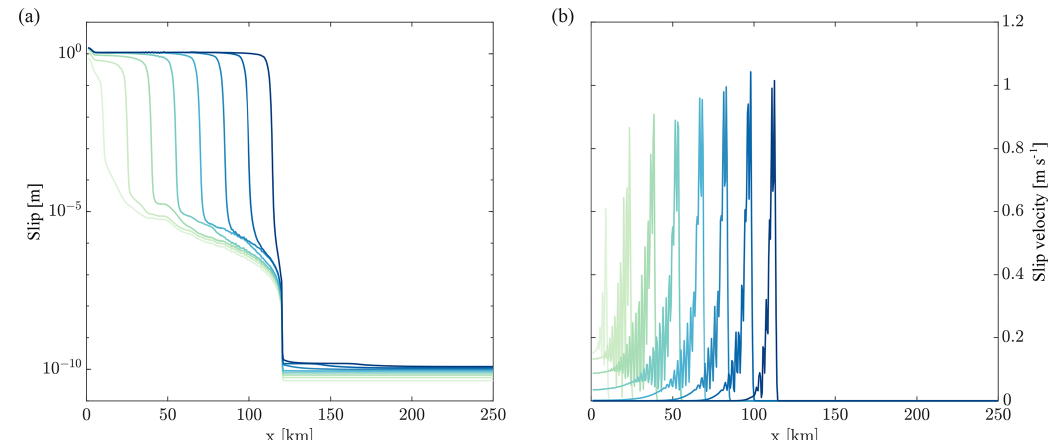
Figure 6. Accumulated plastic slip and slip velocity during the first earthquake on the main fault plotted in 5s intervals.